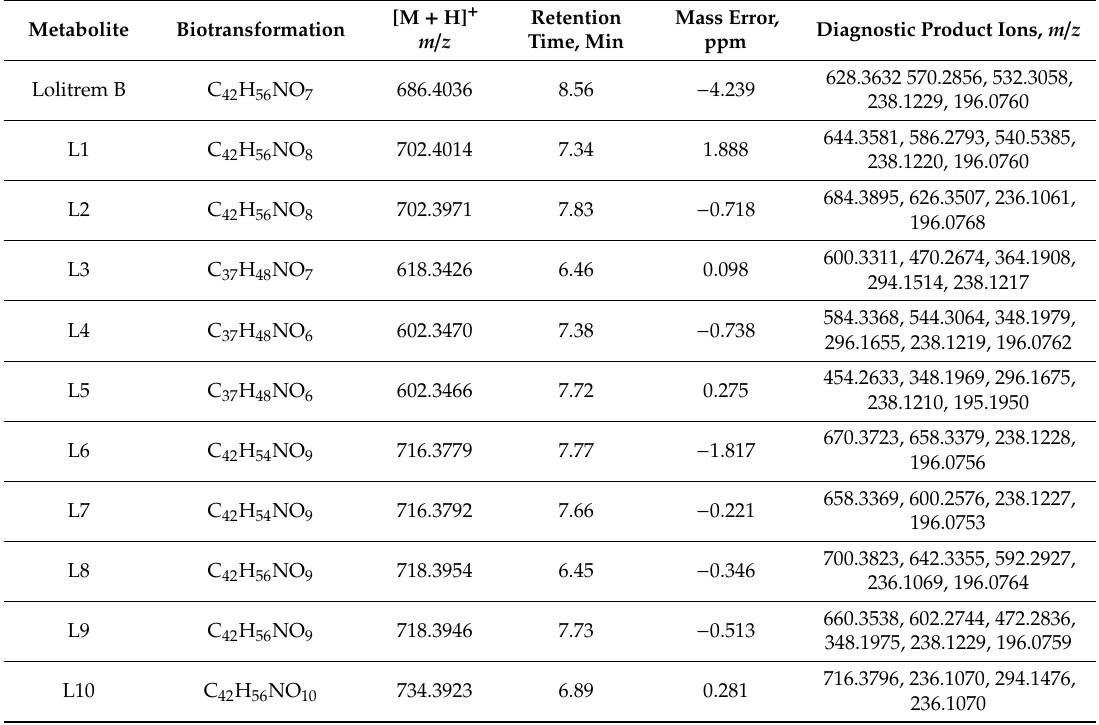
Table 1. Accurate mass molecular ion, retention time, elemental composition, nominal mass for diagnostic product